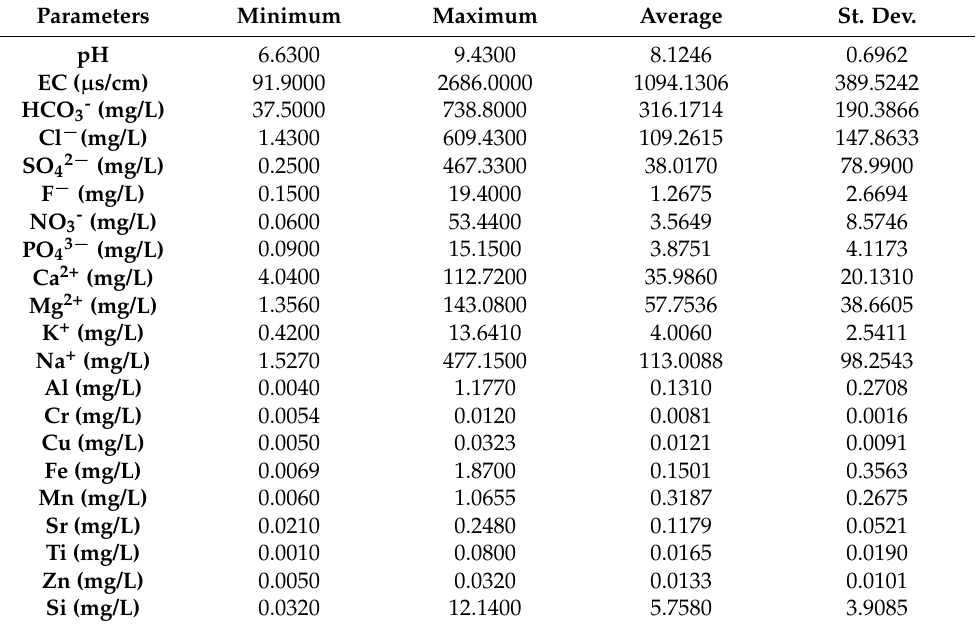
Table 3. Statistical summary for observed water quality